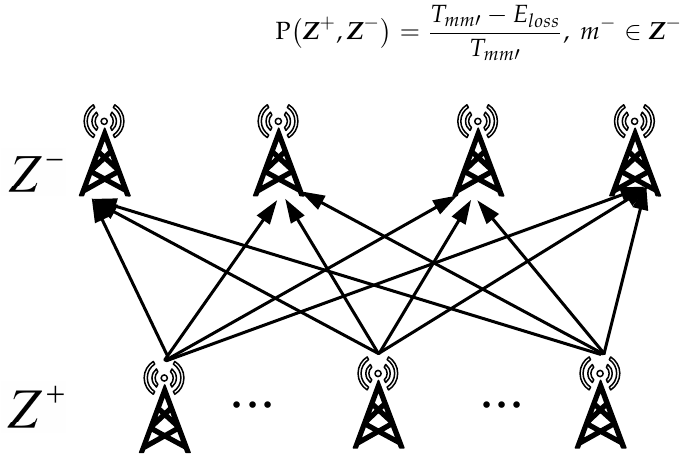
Figure 2. Many ‐ to ‐ many matching of base